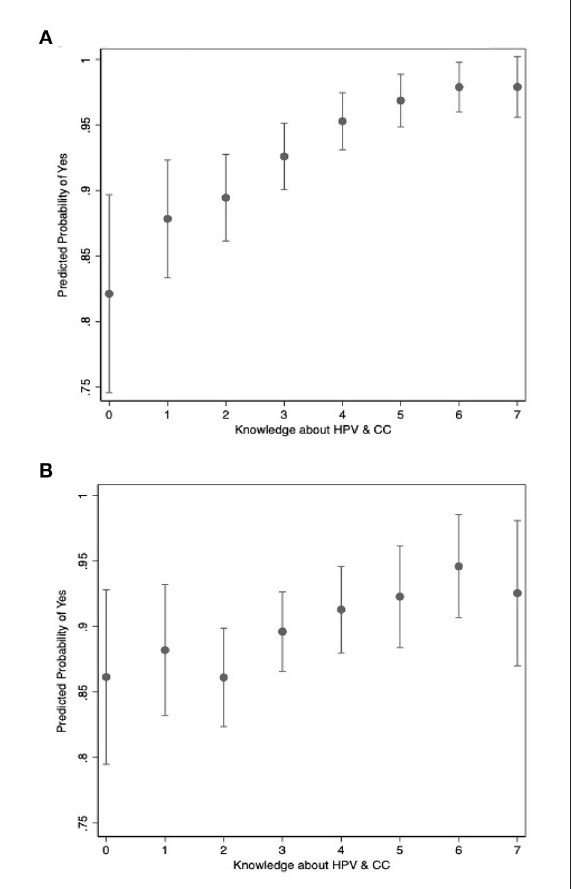
FIGURE5 Relationship between knowledge and motivation. (A) Wanting the HPV vaccine to be available in Mali. Shows the predicted probability that a participant answers “yes” to whether they would like the HPV vaccine to be available in Mali, based on the level of knowledge calculated using the maximum likelihood model described in the text. (B) Wanting to vaccinate your own daughter. Show the predicted probability that a participant answers “yes” to wanting their own child to participate in an HPV vaccination campaign, based on the level of knowledge calculated using the maximum likelihood model described in the